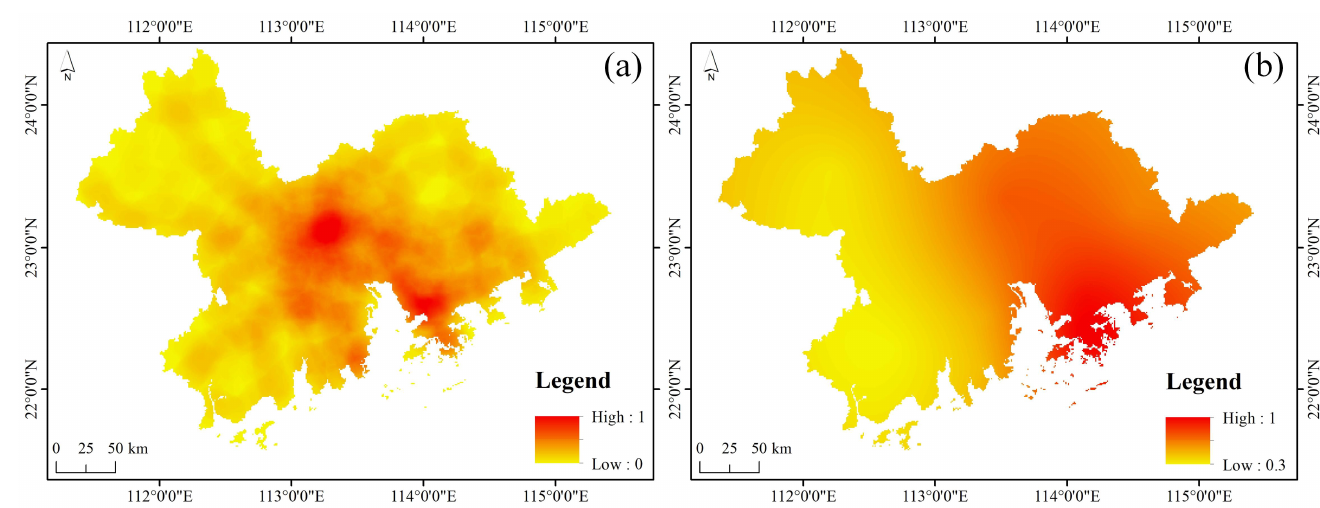
Figure 9. The initial spatial distribution of ESV ( a ) and GDP ( b ). Table 3. The unit ESV and GDP in each land use type.